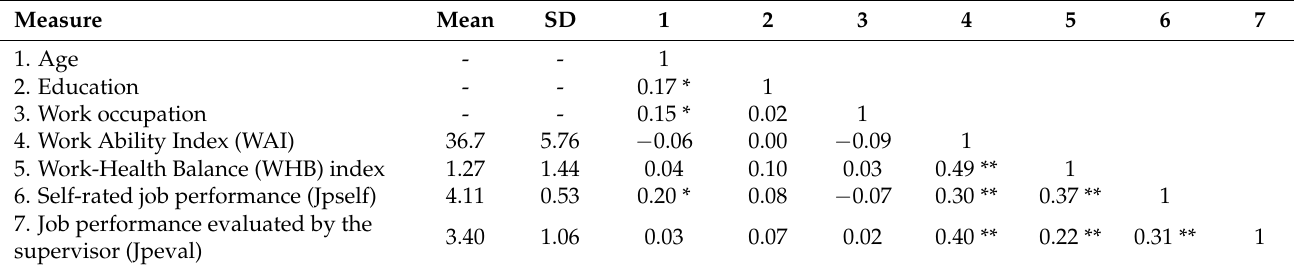
Table 2. Means, standard deviations (SD) and correlations for the WHB index, JPself scale and the WAI and JPeval scores (N = 156).